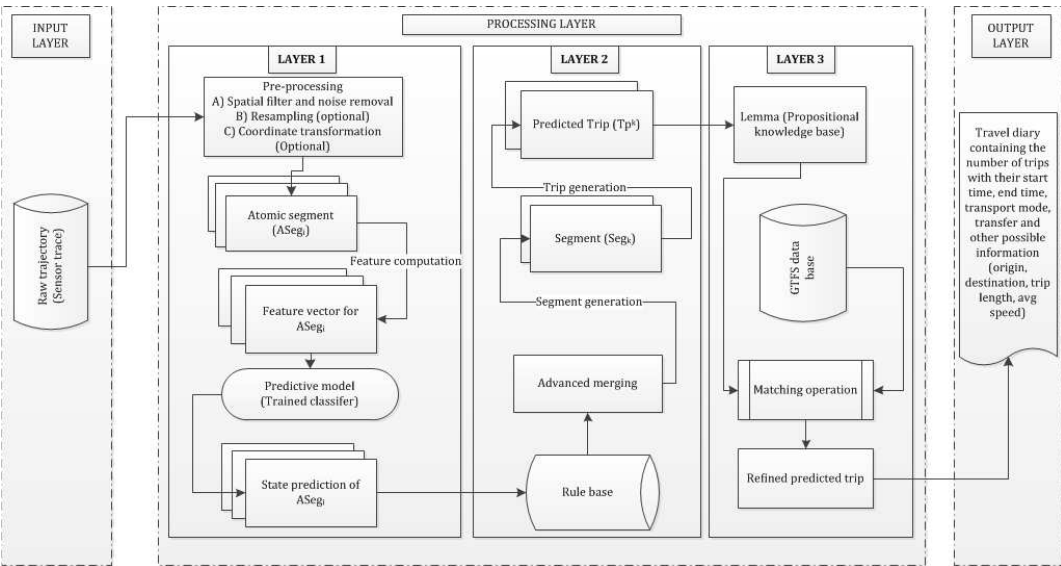
Figure 3. A state-based bottom-up framework for travel dairy